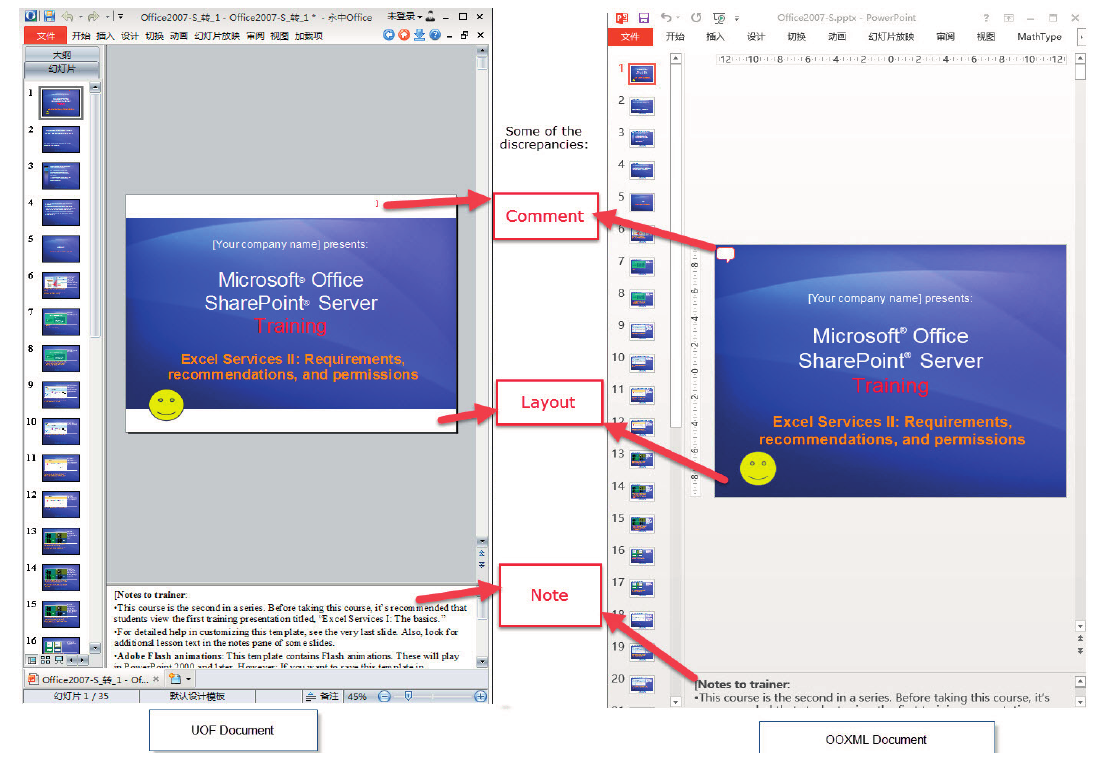
Figure 2. Presentation Translation.